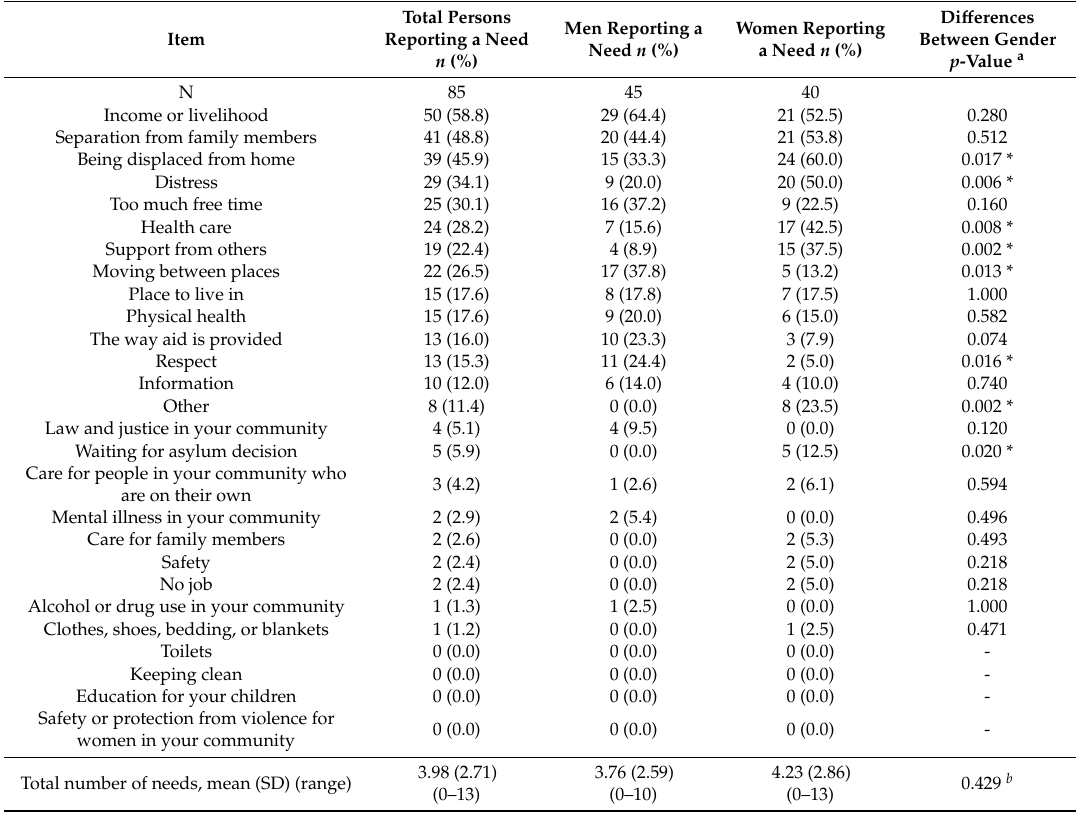
Table 2. Perceived serious needs, item by